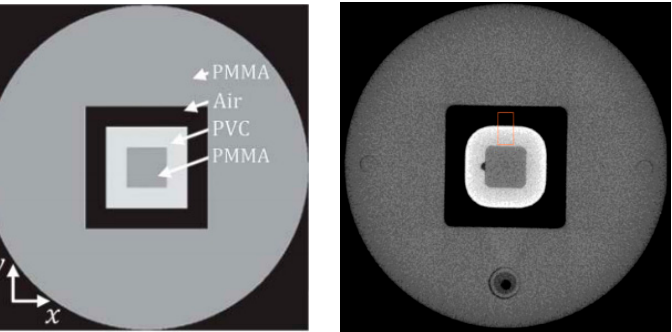
Figure 2. An example of locating and delineating the ROI for determining the modulation transfer behavior.